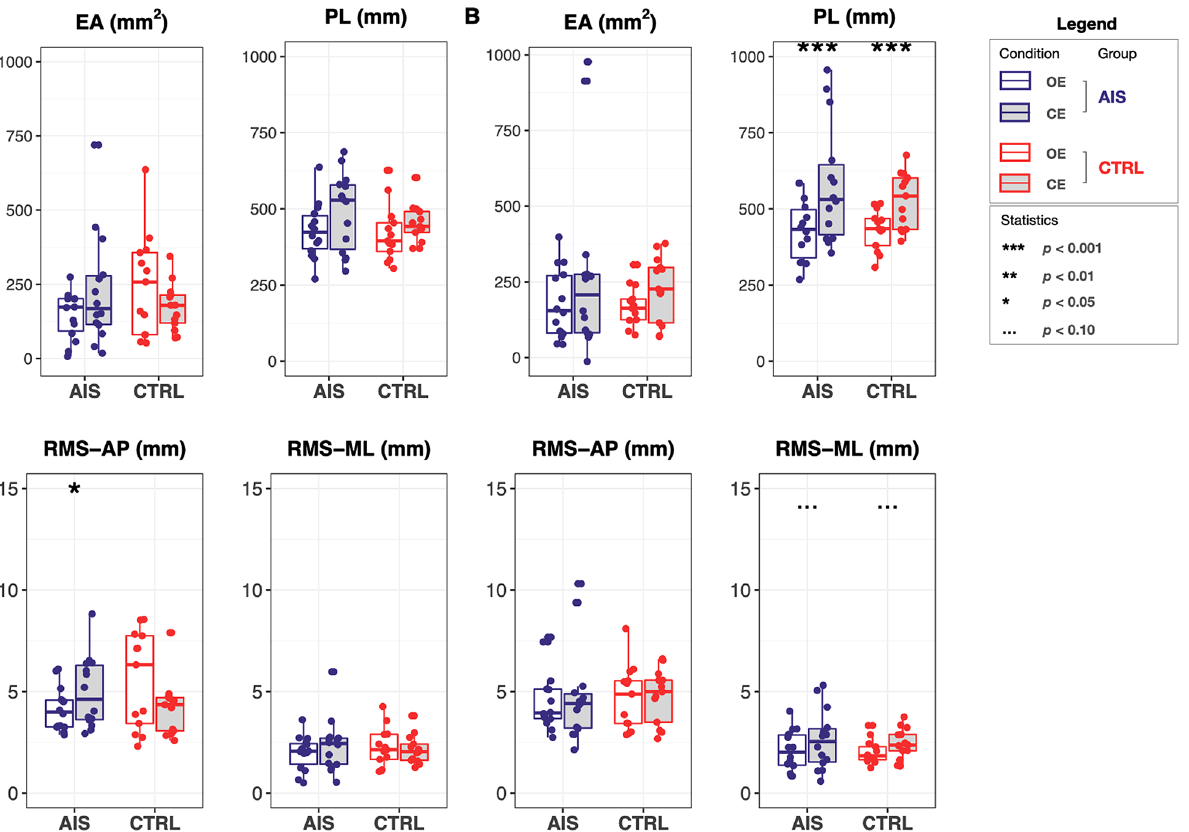
Figure 4. Balance performances as assessed through confidence ellipse area (EA), sway path length (PL) and the root mean square of center of pressure trajectory in the anterior–posterior and medial-lateral directions (RMS-AP and RMS-ML, respectively) in: ( A ) standing , and ( B ) arms up conditions. Boxplots are filled with white for eyes open ( OE ) and gray for eyes closed ( CE ). Statistical results were highlighted with: ‘***’ for p < 0.001 , ‘**’ for p < 0.01 , ‘*’ for p < 0.05 , and ‘...’ for p < 0.10 .